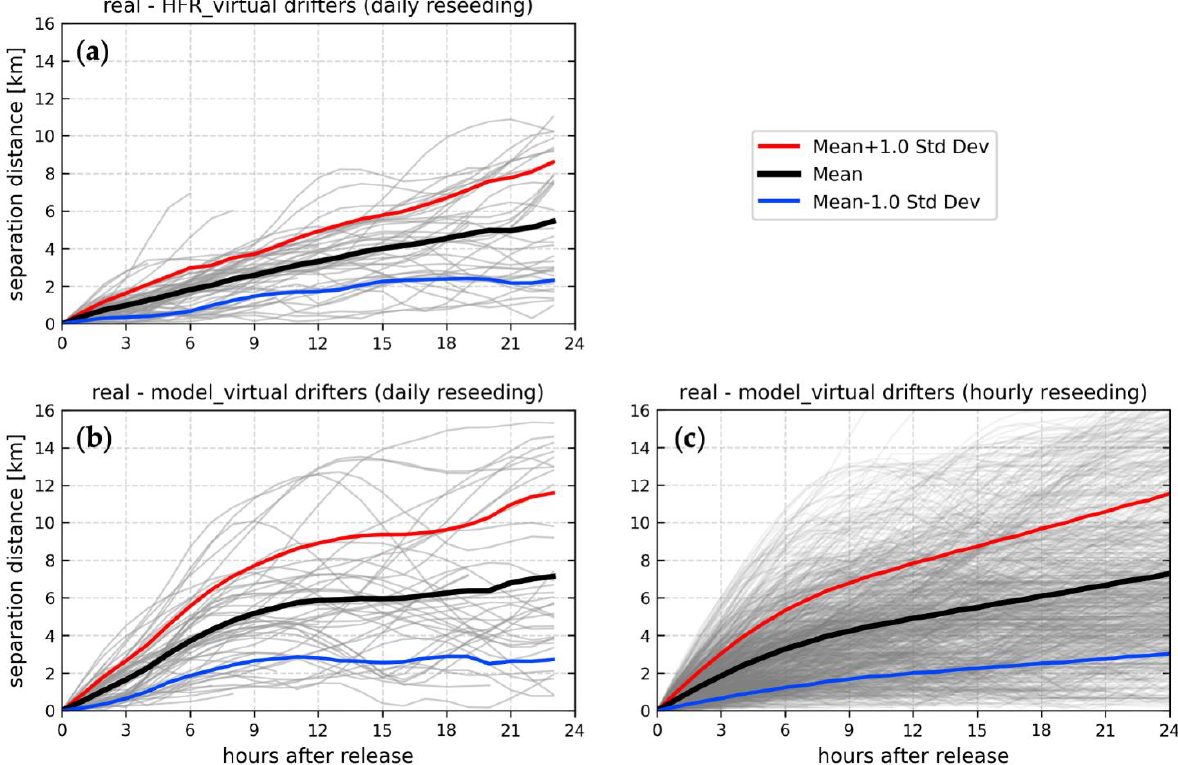
Figure 10. Separation distances between real drifters and (daily reseeded) virtual drifters computed from HFR fields ( a ) and between real drifters and (daily reseeded) virtual drifters computed from model output (simulation RR) ( b ). Separation distance between real drifters and virtual drifters computed from model output by using an hourly reseeding approach ( c ). Std Dev in the legend stands for standard deviation.